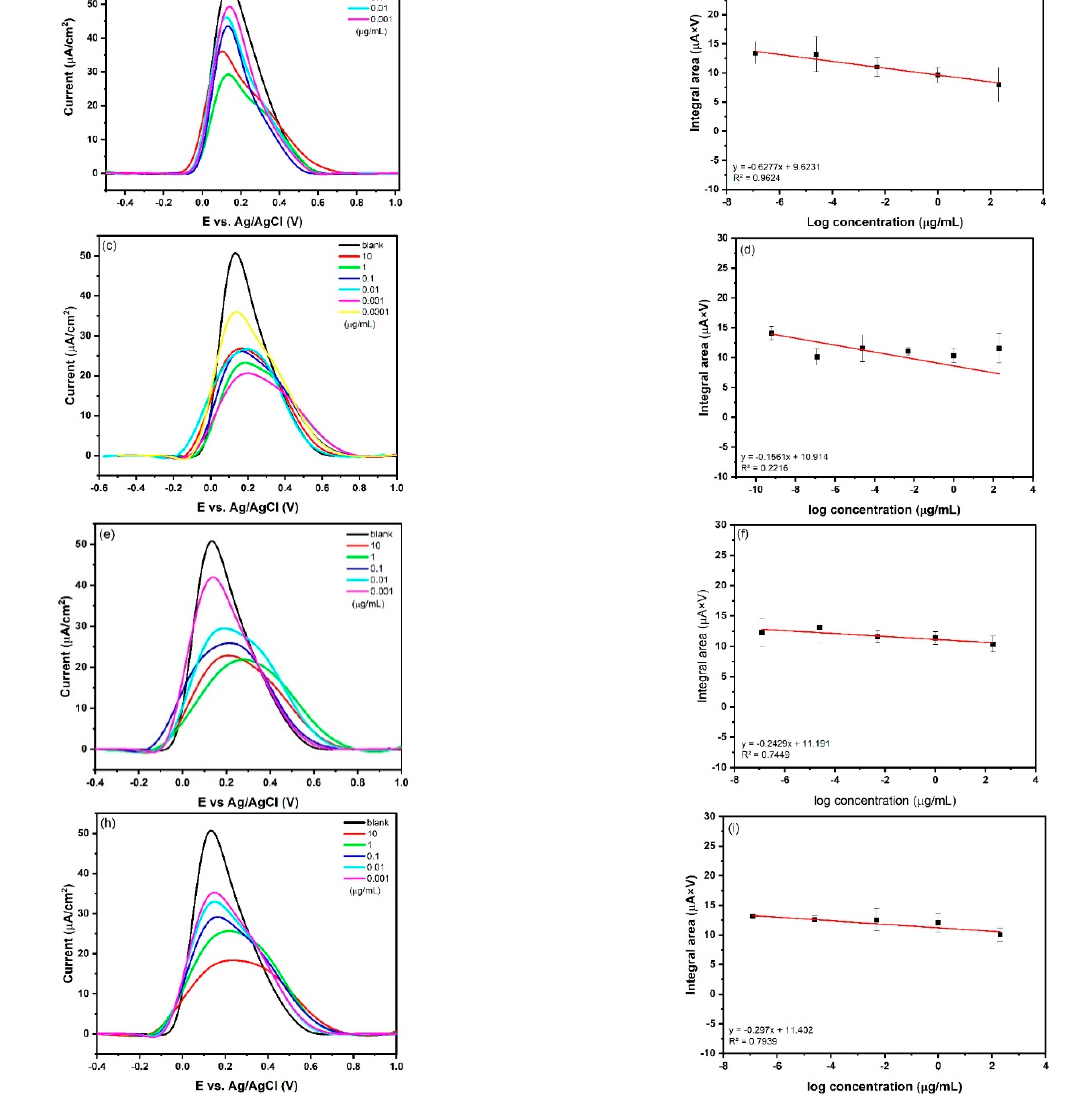
Figure 7. The SWV response of the immunosensor after incubating with different concentrations of CA125 with four carbon nanomaterials ( a ) 50AuNPs@MWCNTs, ( c ) 50AuNPs@VGCFs, ( e ) 50AuNPs@KS4, ( h ) 50AuNPs@SP and calibration curve of the CA125 representing the current density vs. logarithm of the concentration of ( b ) 50AuNPs@MWCNTs, ( d ) 50AuNPs@VGCFs, ( f ) 50AuNPs@KS4, and ( i ) 50AuNPs@SP. (SWV: pulse height (25 mV), pulse width (50 mV), and step height (10 mV)). Table 2. Comparison of immunosensors using different kinds of CBNs for CA125 detection. Table 3. Comparison of some previous biosensors and present biosensor for CA125